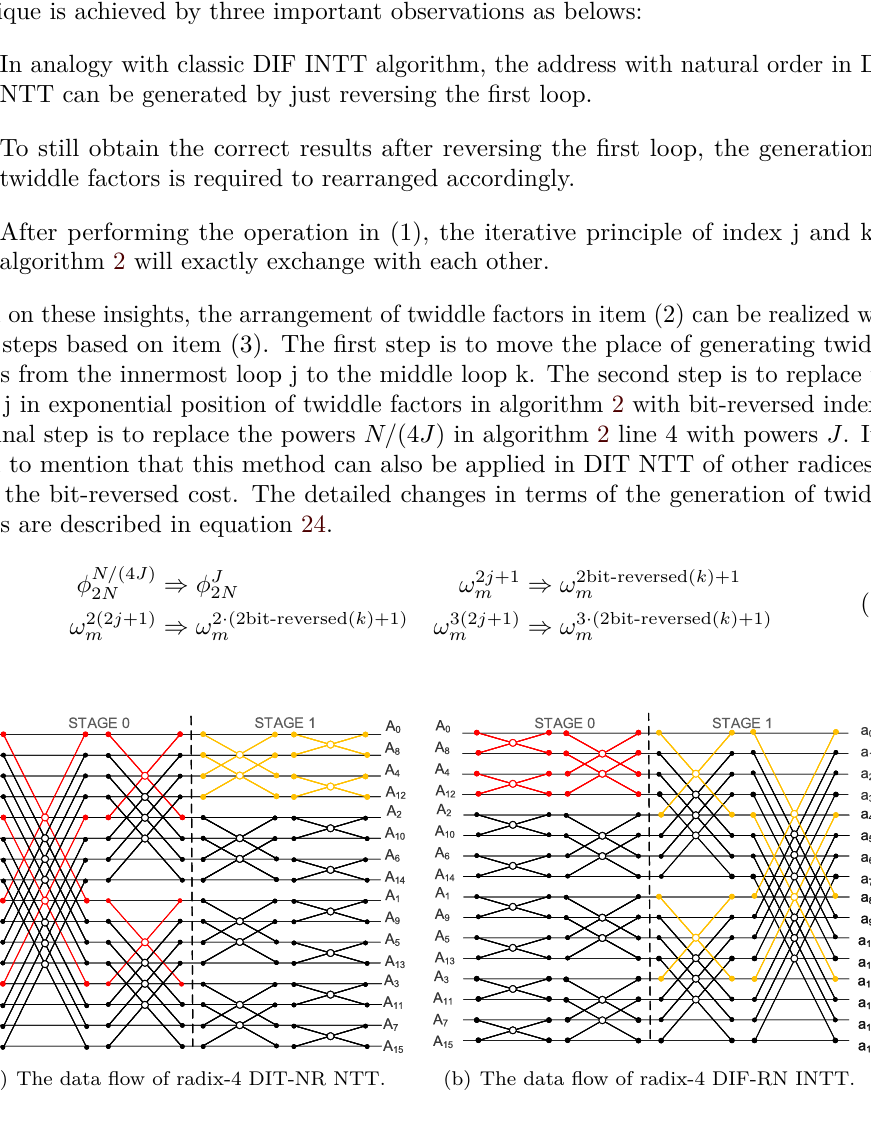
Figure 5: The data flow of 16 points radix-4